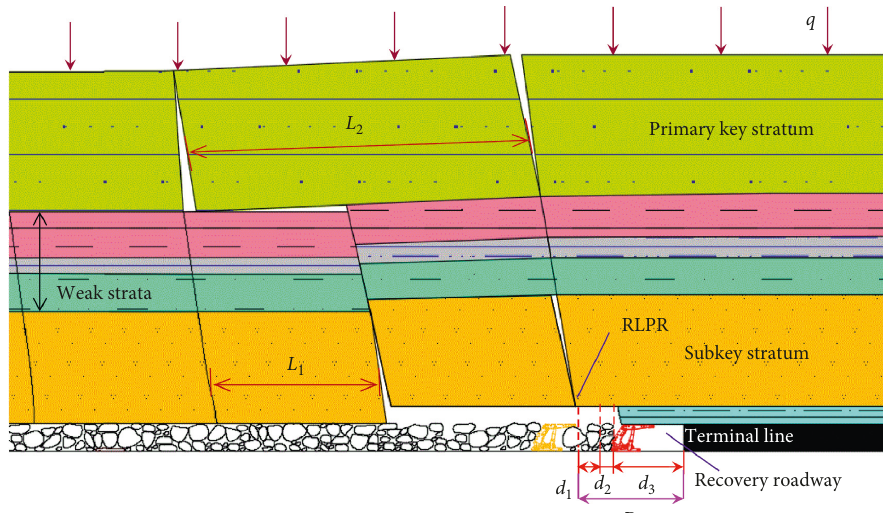
Figure 5: Location model of pressure